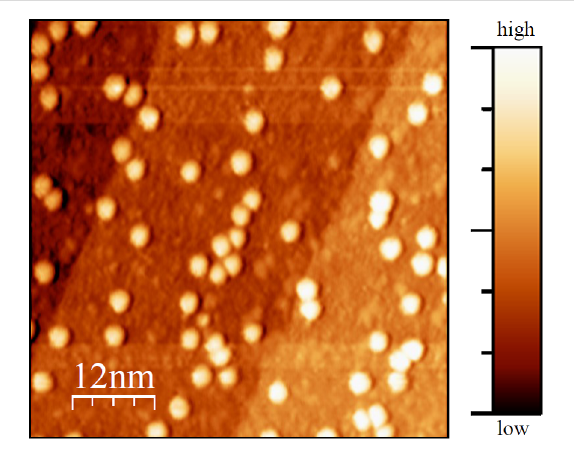
Figure 1: Topographic image ( U = 2 V; I = 0.5 nA) of Er 3 N@C 80 on W(110). The molecules appear as bright round structures on the straight monoatomic steps of W(110). The fullerenes are randomly dis- tributed on the surface. The residual roughness visible in the image most probably emerges from multiple imaging of the molecules due to the imperfection of the tip. The scale bar colors are also representa- tive for all following